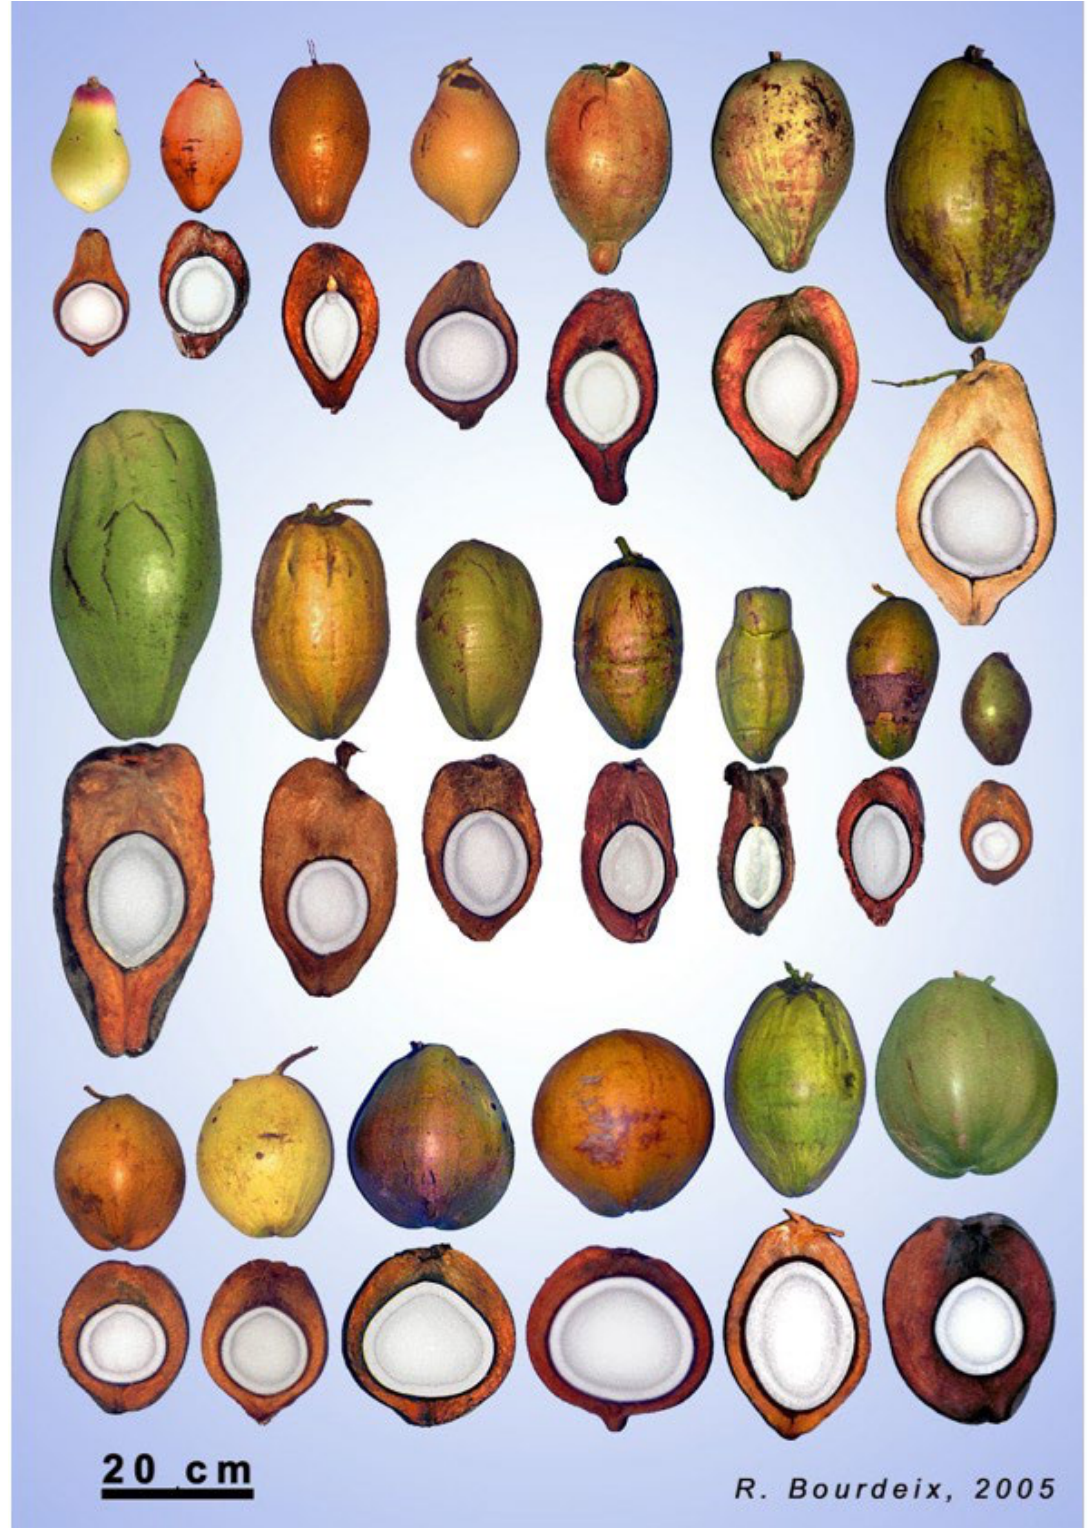
Figure 2. Fruit morphology diversity in different varieties of coconut. Reprinted from Bourdeix Roland, Konan Jean Louis, N’Cho Yavo Pierre. 2005. Coconut. A guide to traditional and improved varieties . Montpellier: Diversiflora, 104 p. (Catalys) ISBN 2-9525408-1-0 [34]. Reprinted with